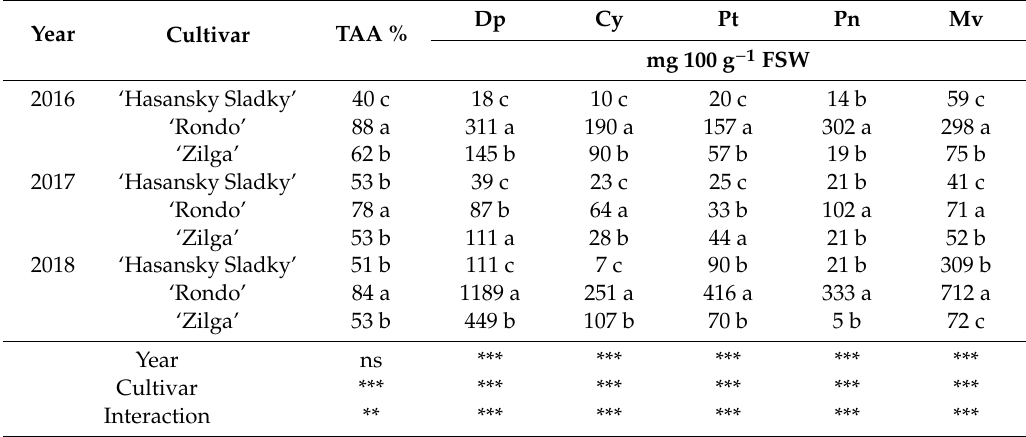
Table 5. The e ff ect of cultivar and year on antioxidant activity and the content of individual anthocyanins’ in grapes of ‘Hasansky Sladky’, ‘Rondo’, and ‘Zilga’ (2016–2018) cultivated in field conditions.